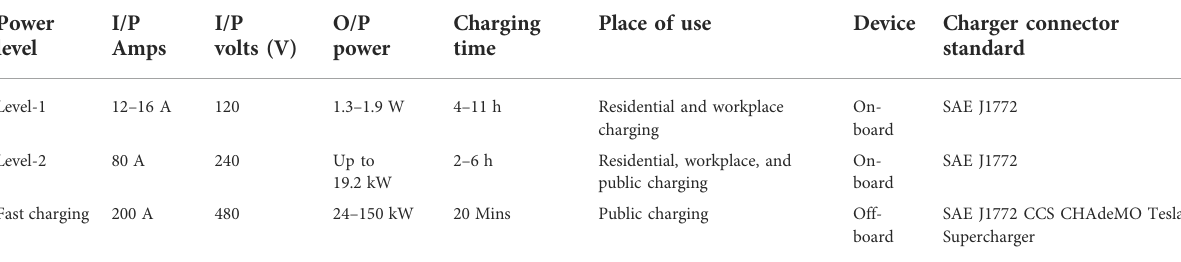
TABLE 1 Electric vehicle charging